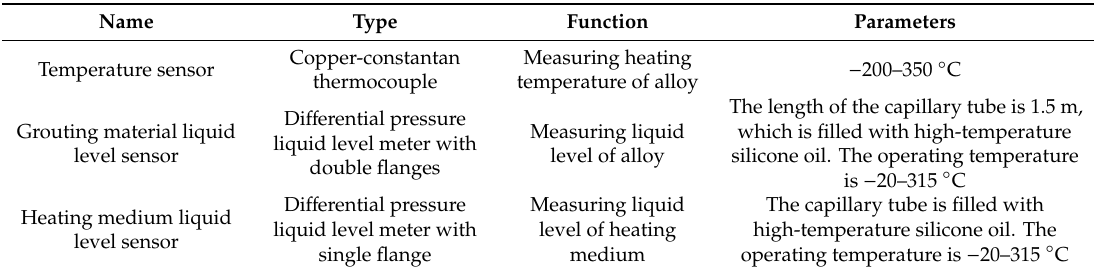
Table 1. Type, function, and parameters of the sensors.